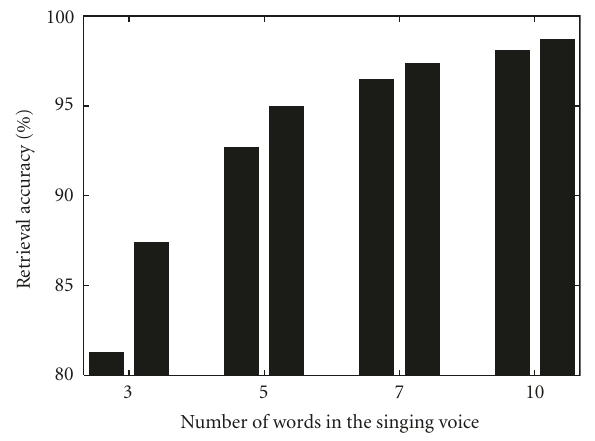
Figure 6: Retrieval accuracy using various number of words.